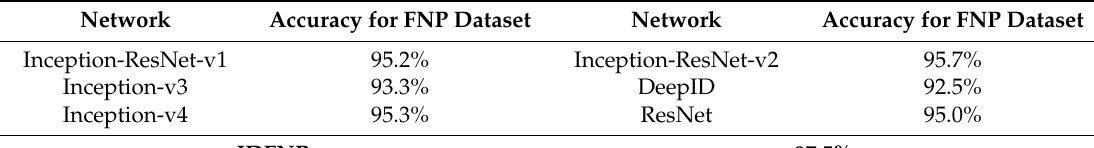
Table 9. Comparison of IDFNP with other classification